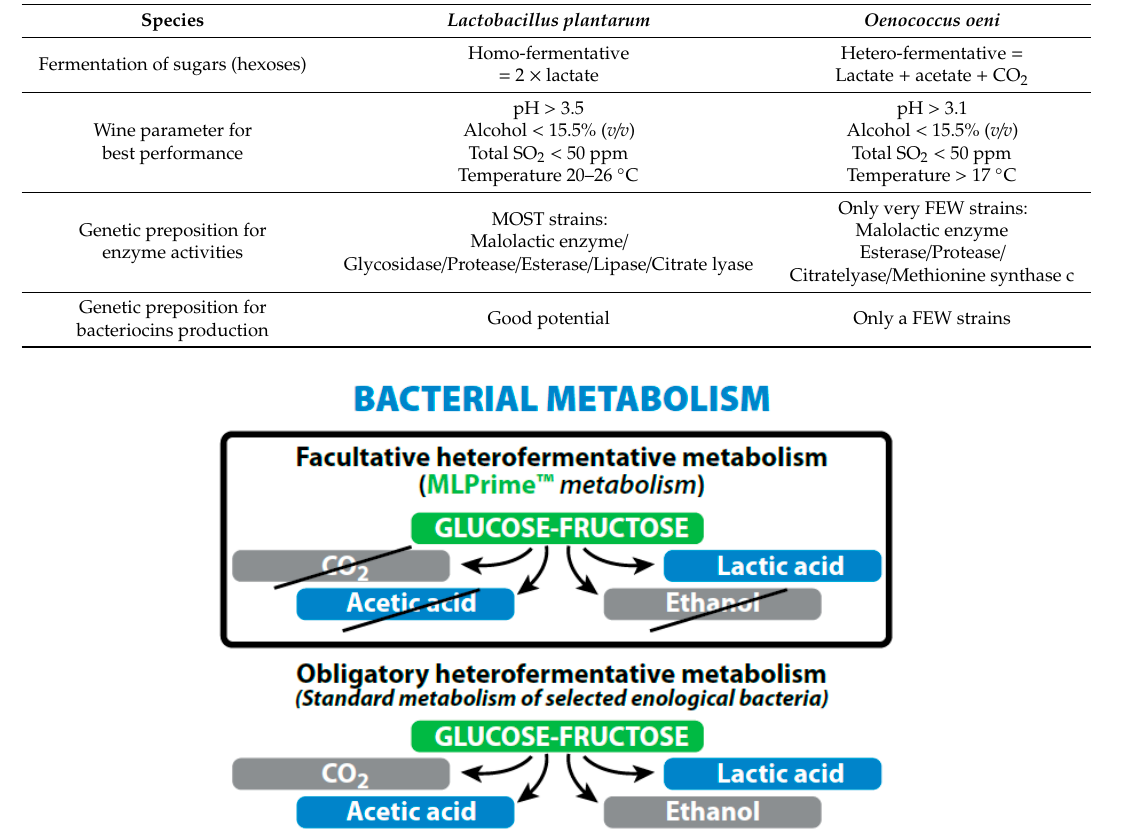
Table 1. Characteristics of Lactobacillus plantarum vs. Oenococcus oeni .